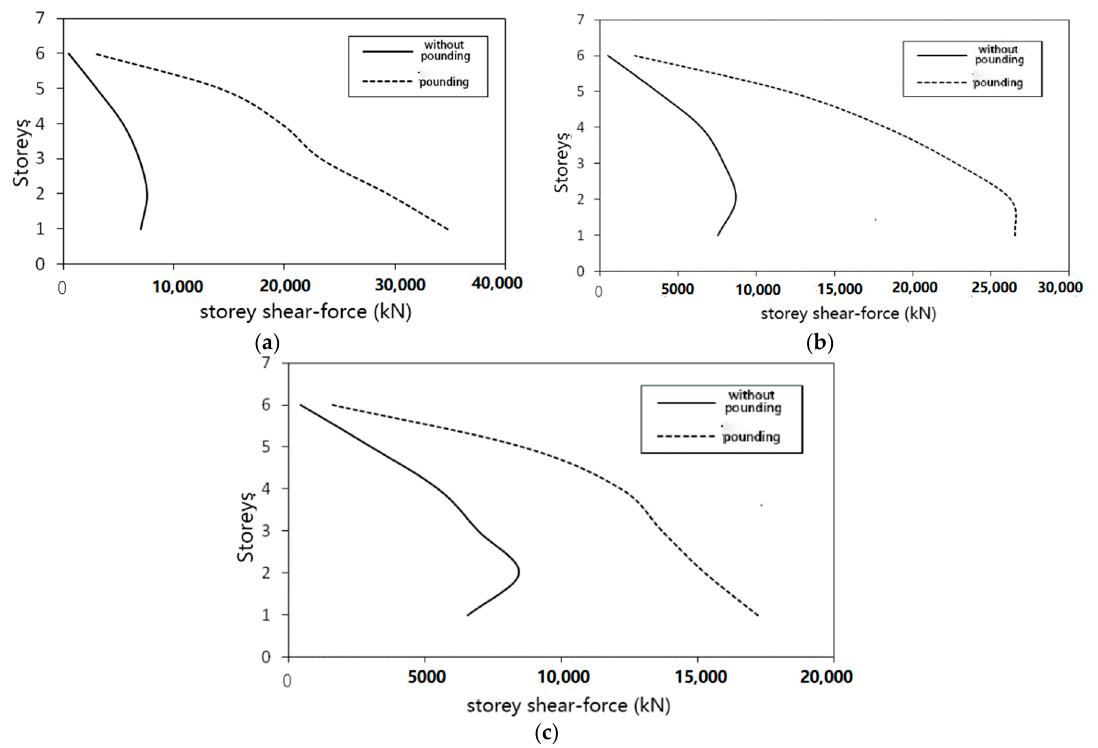
Figure 14. Story shear-force under different earthquakes (model A). ( a ) El Centro earthquake; ( b ) Taft earthquake; ( c ) Artificial excitation.